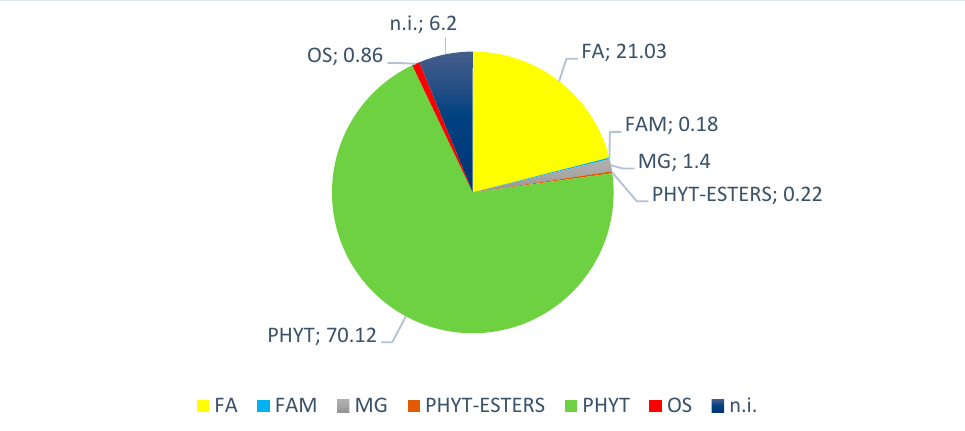
Figure 2. The mean relative content of the main chemical classes for hexane extract according to features identified in the GC-MS dataset. FA: free fatty acids; FAM: fatty acid methyl esters; MG: monoglycerides; PHYT-ESTERS: phytosterol esters; PHYT: free phytosterols; OS: other steroids; n.i.: not identified.